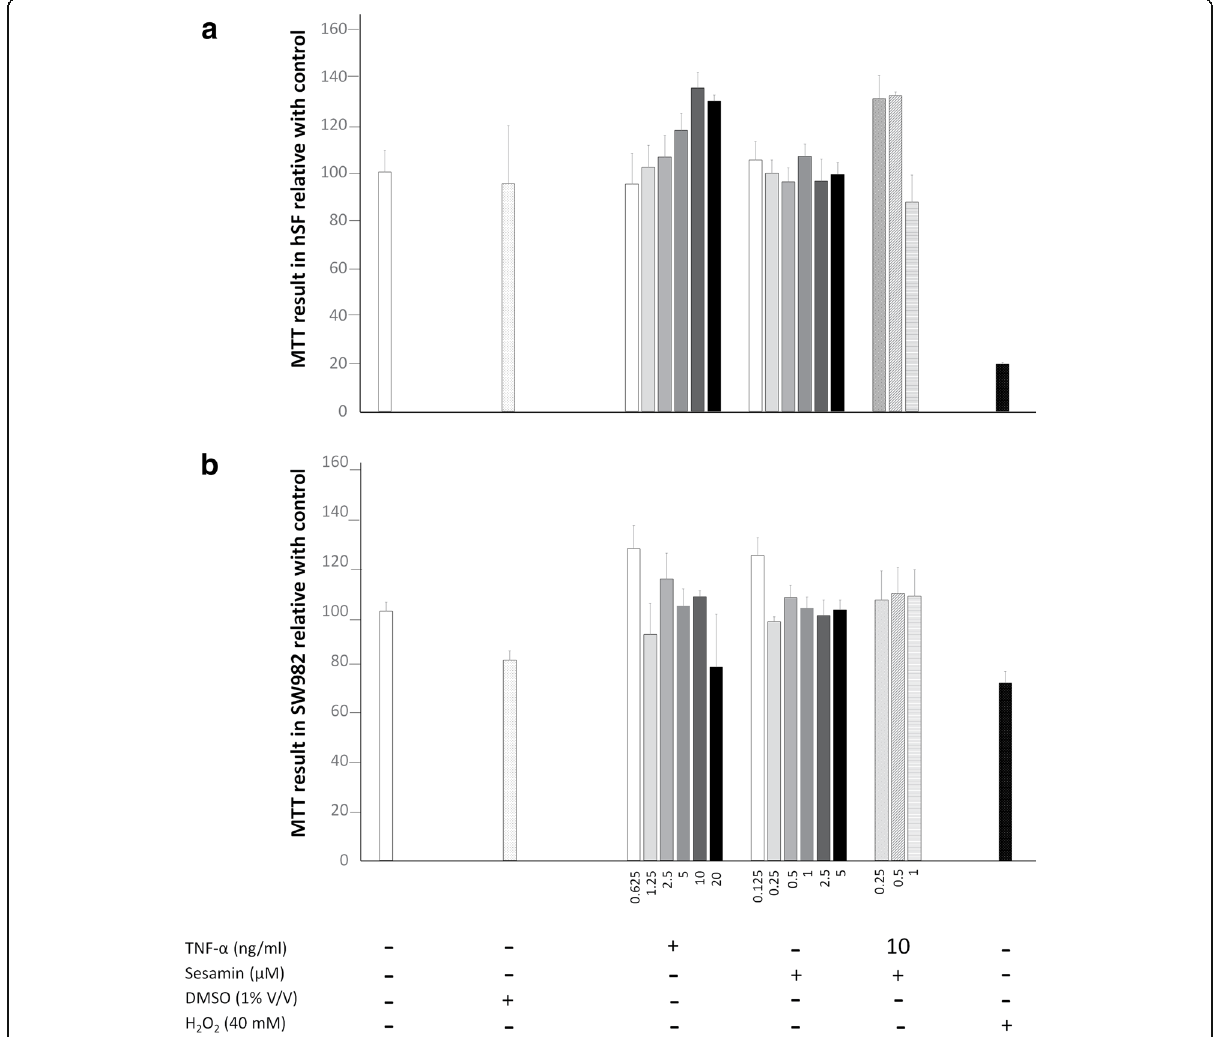
Fig. 1 Cell viability testing of hSF and SW982 cells. Cell viability testing was performed by the MTT assay as described in the Materials and Methods section. a Cell viability results for hSF cells under TNF- α alone, sesamin alone or combinations of TNF- α and sesamin. b Cell viability results for SW982 cells under TNF- α alone, sesamin alone or combinations of TNF- α and sesamin. Values are presented as the mean±SEM ( n